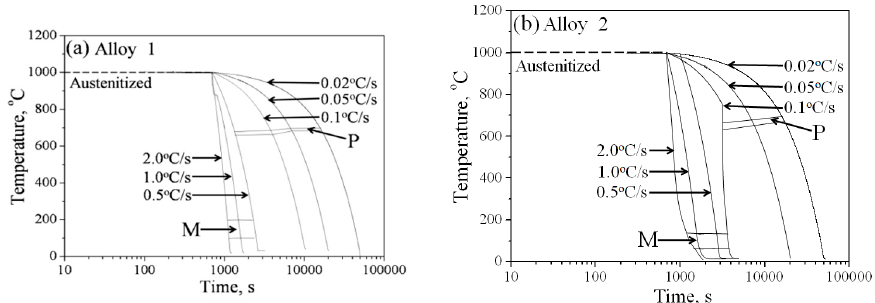
Figure 4. The CCT (Continuous Cooling Transition) curves of the tested steels: ( a ) Alloy 1 and ( b ) Alloy 2.